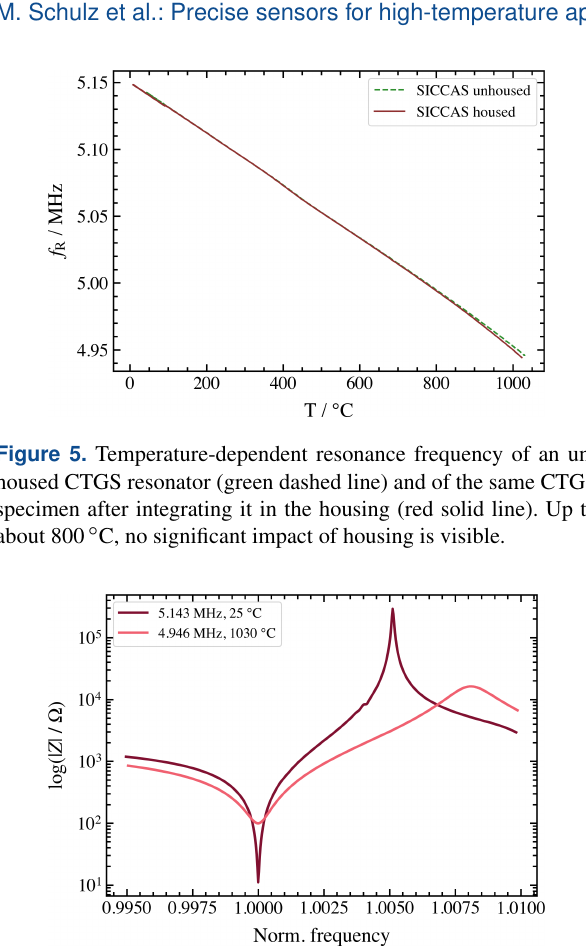
Figure 6. Modulus of CTGS impedance measured at room temper- ature and at 1030 ◦ C. The frequency is normalized to the resonance frequency (see the legend) at a given temperature.